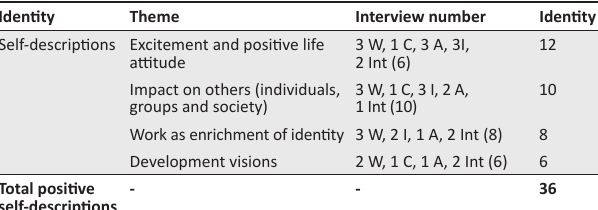
TABLE 5: Positive self-descriptions of women leaders.